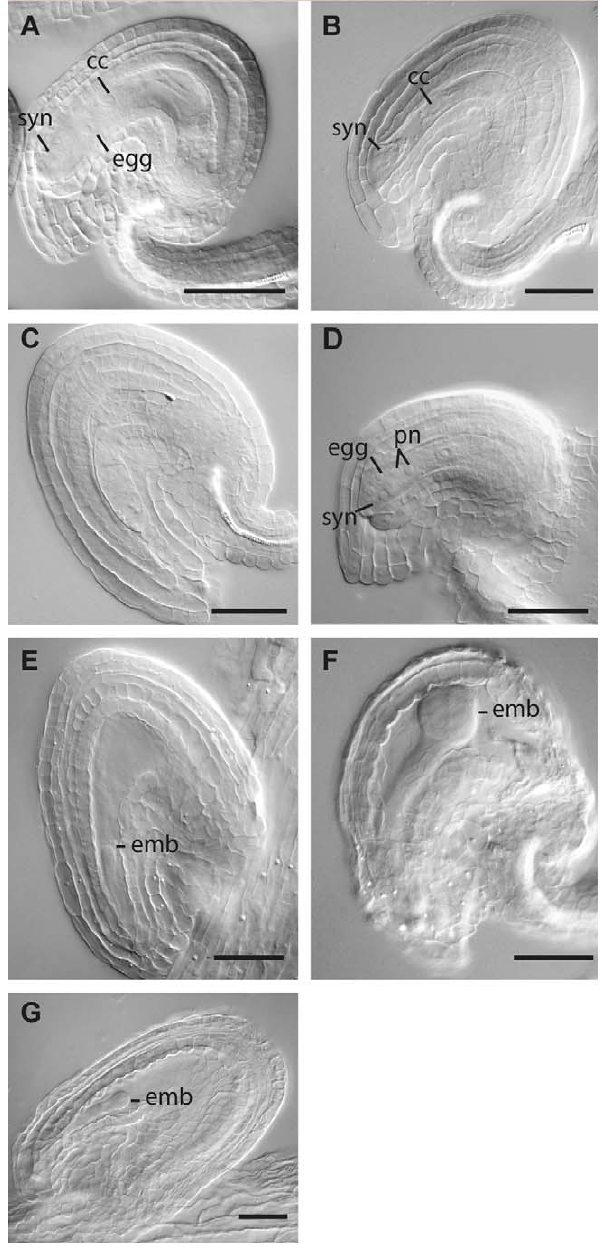
Figure 6. Phenotypic analysis of mem-1 and mem-2 mature gametophytes and early embryogenesis. (A) Wild-type embryo sac. (B–D) Typical phenotypes observed in mature female gameto- phytes of plants heterozygous for mem-1 . Abnormally narrow shaped embryo sacs (B), ovules with differentiated sporophyte but without discernible gametophyte (C), and gametophytes with unfused polar nuclei (pn) were observed (D). (E–G) Arrest of embryonic development in mutants heterozygous for mem-1 (E, F) or mem-2. (F) Embryo developmental arrest was typically observed latest at globular stage. (A–G) Scale bars are 40 m m; egg, egg cell; syn, synergids; cc, central cell; emb, embryo; pn, polar nuclei. doi:10.1371/journal.pbio.1001155.g006 As the MEM gene was identified as significantly enriched in the MMC, this finding suggests that either (I) carryover of stable transcripts present in the MMC of a heterozygous plant is enough to sustain later stages until early seed development, (II) transcripts